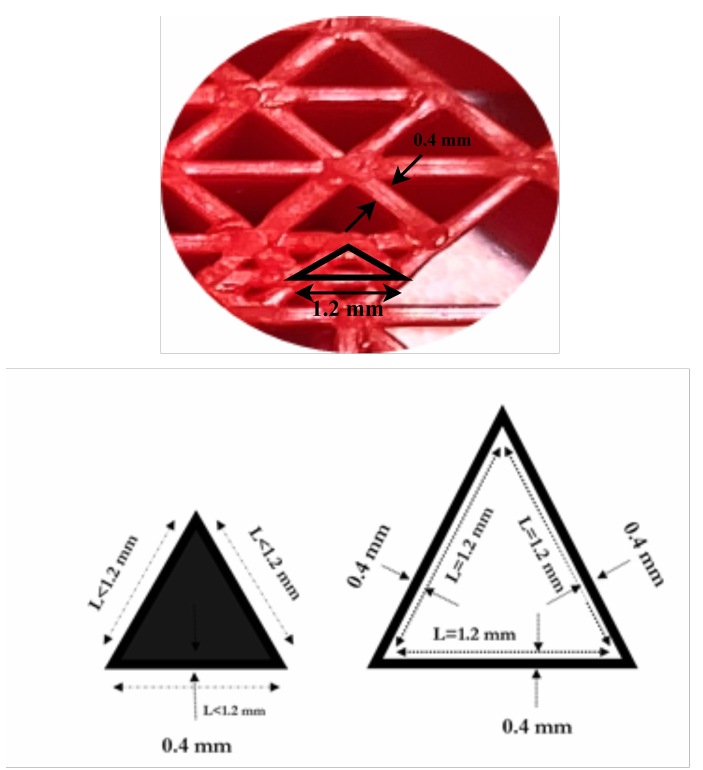
Figure 4. Size limitation of triangular infill